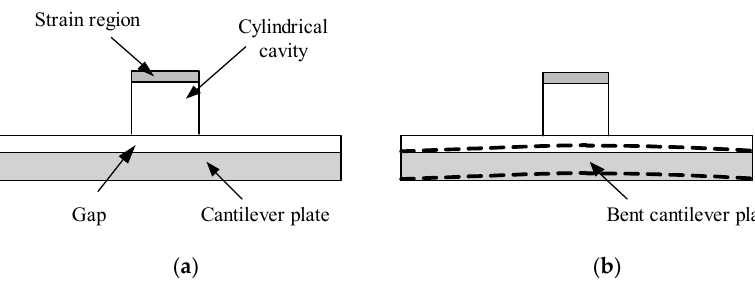
Figure 5. Schematic of measuring principle of acoustic filtering sensor. ( a ) The sensor structure under normal conditions; ( b ) The sensor structure when being squeezed and bent.